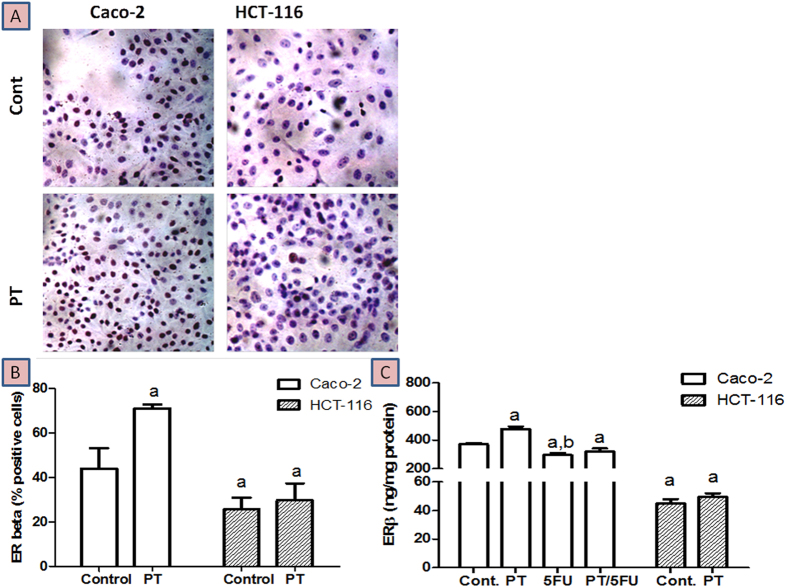
Effect of PT on the protein expression of ER-β in Caco-2 and HCT-116 colon cancer cell lines using immunocytochemistry (A,B) and ELISA assay (C).Data are means ± SD (n = 3). The experiment was done in triplicates. a indicates significant difference from Caco-2 control at p < 0.05. b indicates significant difference from Caco-2/PT group at p < 0.05.